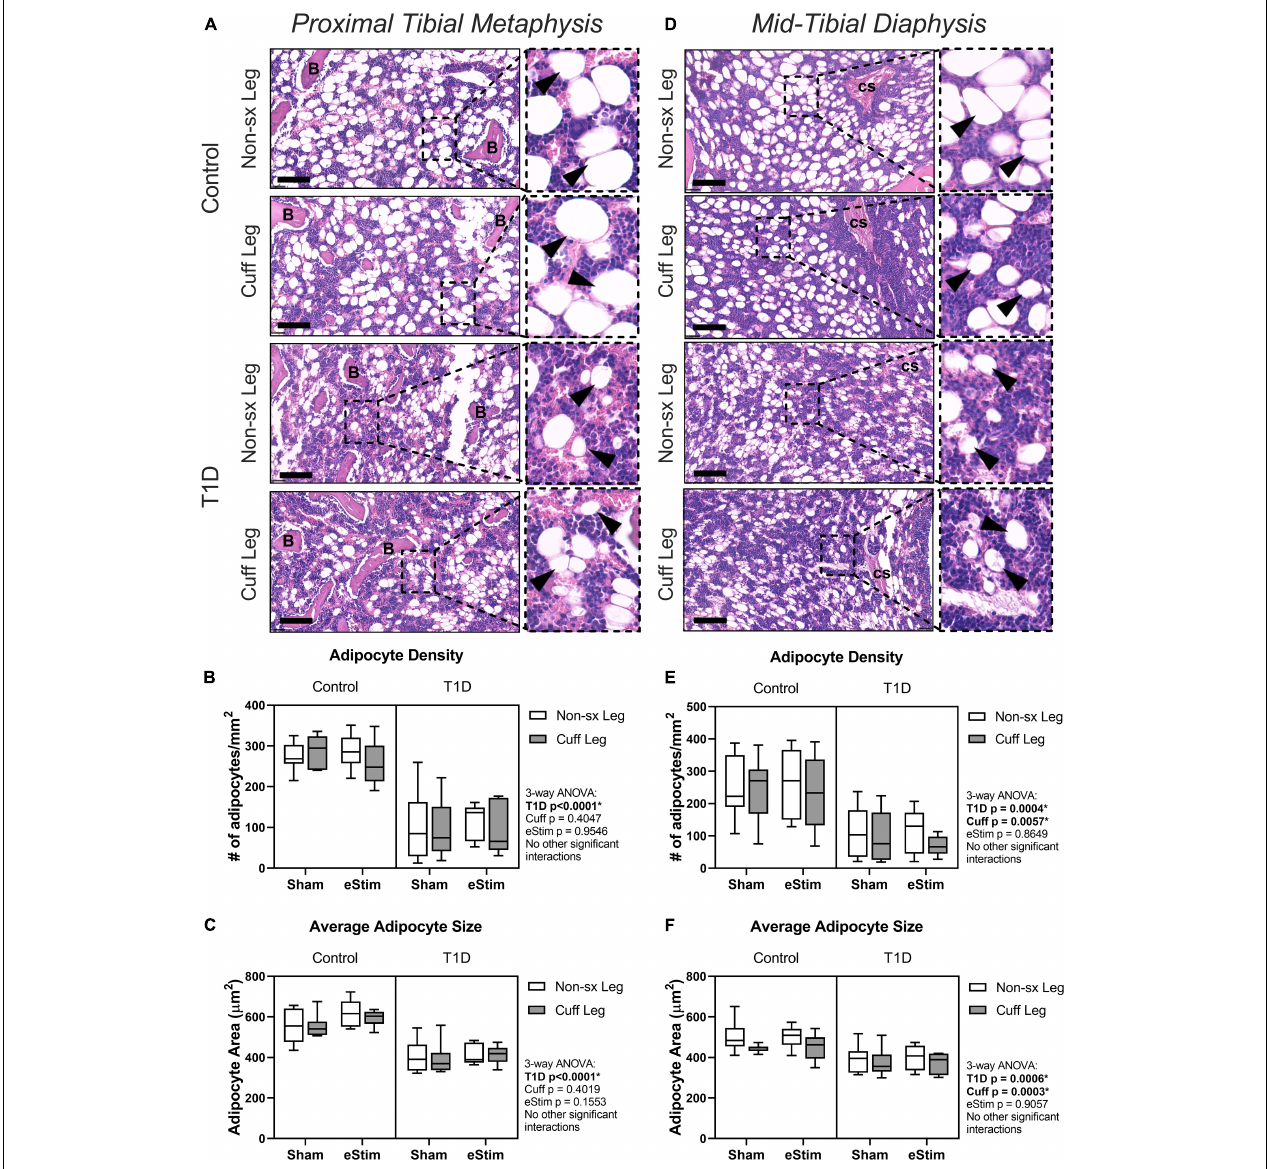
FIGURE 7 | Bone marrow adipose tissue. Bone marrow adiposity was analyzed in the metaphysis 2 mm below the growth plate and in the mid-diaphysis. (A) BMAT histology in the metaphysis in healthy and control animals. (B) Adipocyte density in the metaphysis. (C) Average adipocyte size in the metaphysis. (D) BMAT histology in the diaphysis in health and control animals. (E) Adipocyte density in the diaphysis. (F) Average adipocyte size in the diaphysis. B = bone; cs = central venous sinus. Scale = 100 µ m. (Control, sham n = 7; Control, eStim n = 6; Diabetic, sham n = 8; Diabetic, eStim n = 5) three-way ANOVA with repeated measures (Non-sx Leg vs. Cuff Leg); * p <